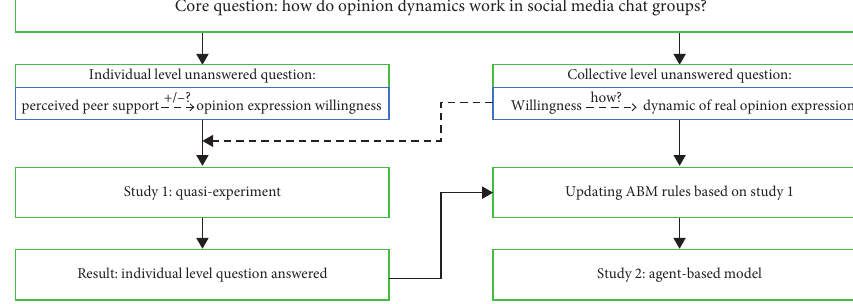
Figure 1: The workflow between study 1 and study 2. Table 1: Quasi-experimental participants